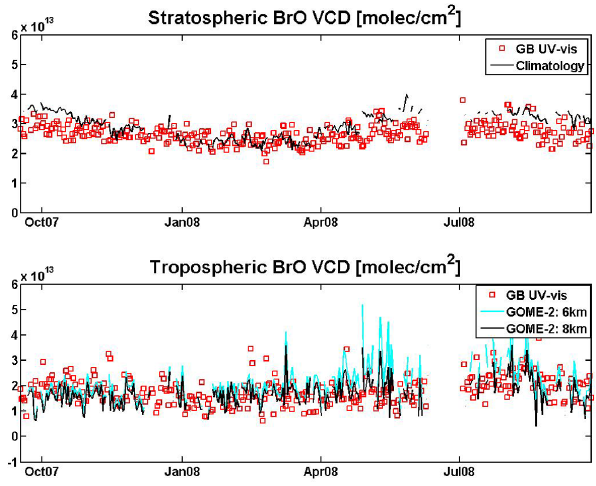
Fig. 6. Comparison between GOME-2 and ground-based strato- spheric (upper plot) and tropospheric (lower plot) BrO vertical columns, at Harestua for the period 2007–2008. Two assumptions are made in the GOME-2 retrieval algorithm for the height (6km: blue line, 8km: black line) of the maximum tropospheric BrO con- centration (see text).